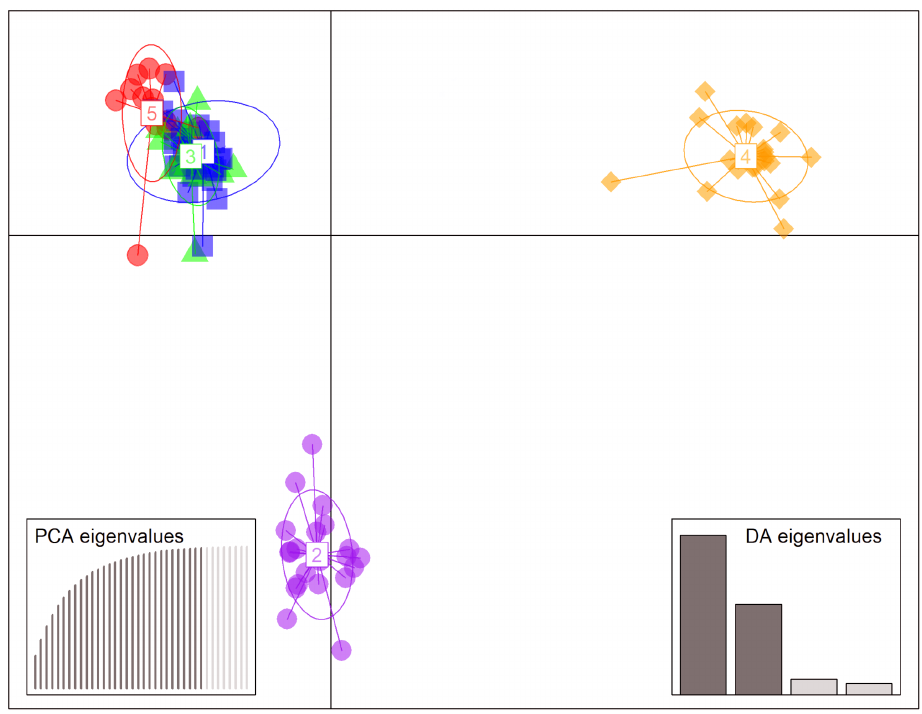
FIGURE 3 | Scatterplot of the Discriminant Analysis of Principal Components (DAPC) of Lophiosilurus alexandri genotypes from captive broodstocks (Bebedouro, Paulo Afonso, and Itiúba (clusters 1, 3, and 5) and wild samples taken from two stretches of the São Francisco River (upper (cluster 2) and submiddle (cluster 4). Clusters are shown by different colors and inertia ellipses, while dots represent individuals. Eigenvalues of the analysis are displayed in